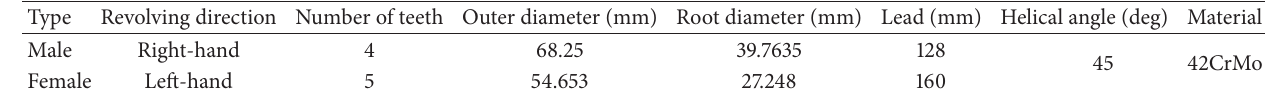
Table 2: The parameters of rotor.